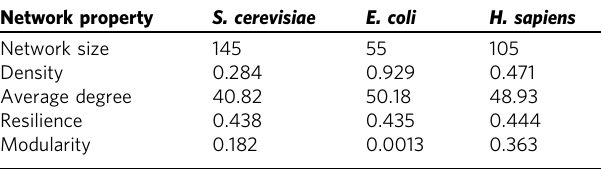
Network size is number of nodes/proteins. Network density is the fraction of the actual amount ofedgesoverthe possibleamountofedges.Averagedegreeistheaveragenumberof edgesper node. Resilience and modularity are described in further detail in section “ Network modularity ” and Supplementary Note